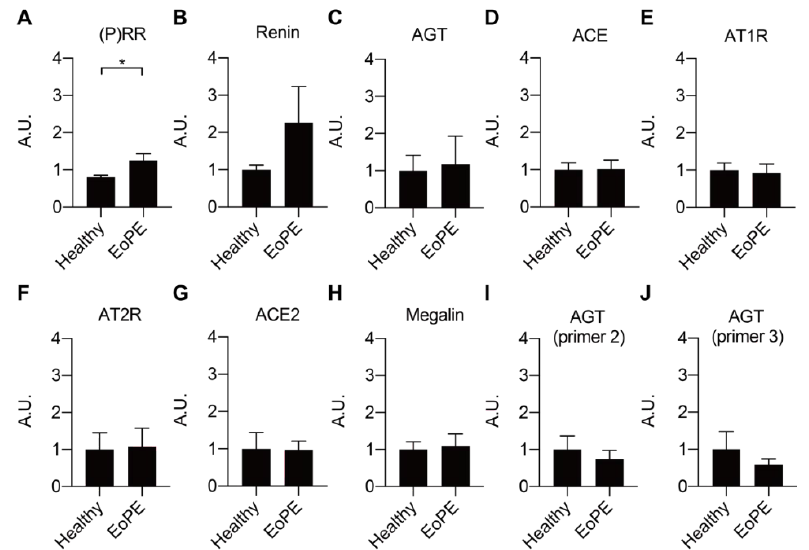
Figure 1. Gene expression levels of RAS components ( A – G ) and megalin ( H ) in healthy and early- onset pre-eclamptic (EoPE) placental tissue. ( I , J ): AGT expression was confirmed with different pairs of primers. Data are mean ± SEM of n = 12. * p < 0.05. ( P)RR , (pro)renin receptor; AGT , angiotensin- ogen; ACE , angiotensin-converting enzyme; AT1R , angiotensin II type 1 receptor ; AT2R , angiotensin II type 2 receptor; A.U., arbitrary unit.